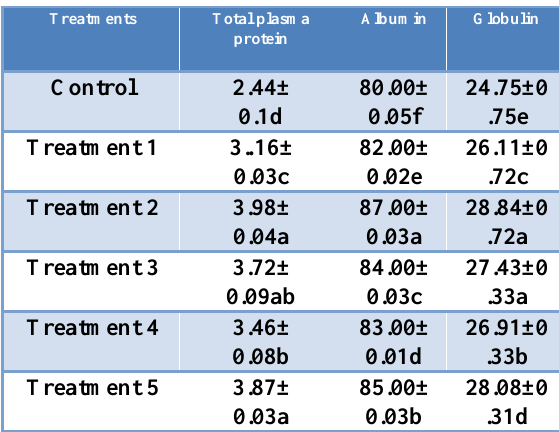
Table,2: Effect of ginger and garlic in carp fish total plasma protein, albumin and globulin concentration in gm /l